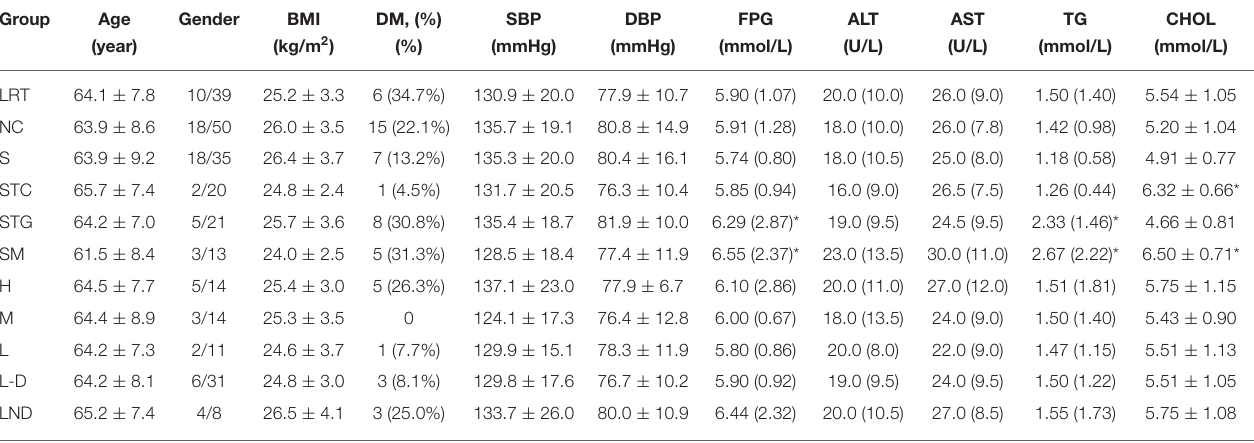
TABLE 1 | Basal physiological data analysis according to different grouping